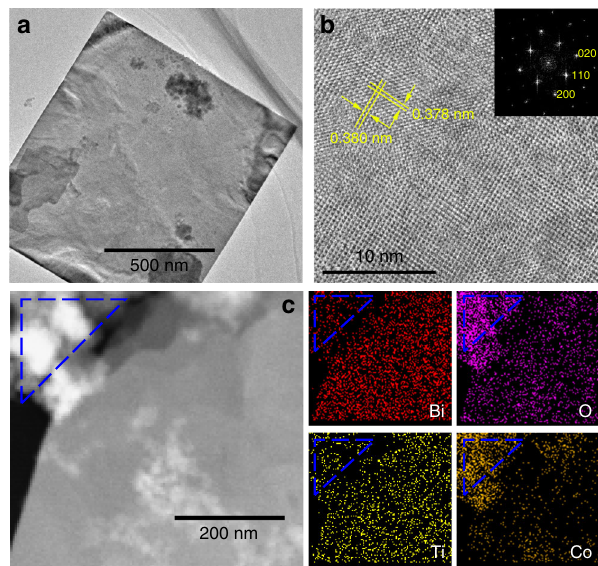
Fig. 2 Morphology of the Co2 sample. a TEM image to show the typical morphology; b HRTEM image of the nanoplate in Fig. 2a with the inset of the corresponding SAED pattern; c STEM image and the corresponding EDS element mapping